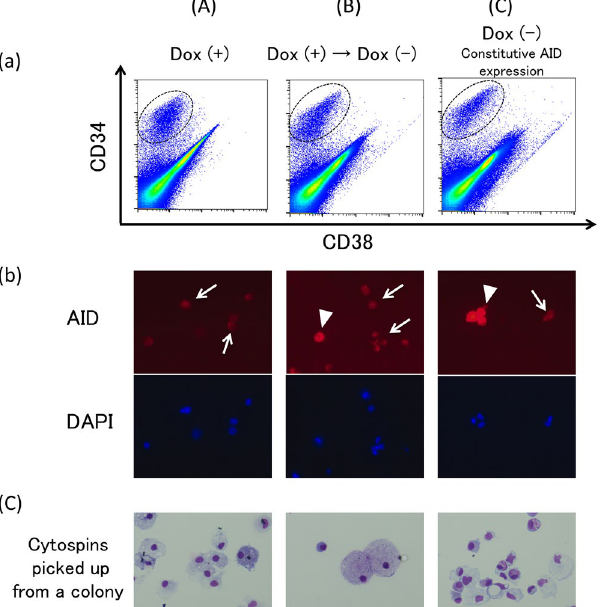
Figure 6. Hematopoietic differentiation from BiPSC13 with AID expression induced using the doxycycline- controlled (Tet-off) system. ( a ) Flow cytometric analysis of the cell phenotype after differentiation of BiPSC13#1-AID into hematopoietic progenitors. The population of CD34-positive cells is surrounded by a dotted line. (A) BiPSC13#1-AID were cultured in the presence of doxycycline, (B) Originally, BiPSC13#1-AID were cultured in the presence of doxycycline to inhibit expression of AID, and subsequently, doxycycline was withdrawn 10 days before sorting of the CD34-positive cells, and (C) BiPSC13#1-AID were cultured in the absence of doxycycline to express AID constitutively. ( b ) Immunofluorescence analysis of the expression of AID in the sorted CD34-positive cells. AID expressed cells were detected in (B) and (C) partially. Arrow heads and arrows indicate AID-positive or –negative cells, respectively. Culture condition of (A), (B), and (C) are as described in ( a ). ( c ) Wright staining of cytospins picked up from a colony (x400). Culture condition of (A), (B), and (C) are as described in ( a